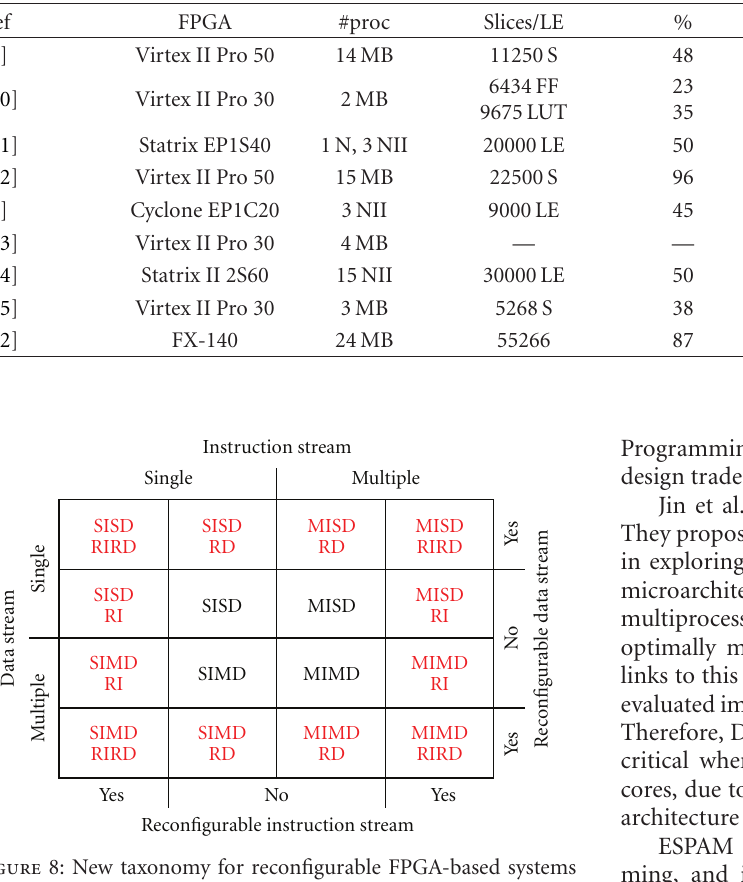
Table 5: Area-performance relation.